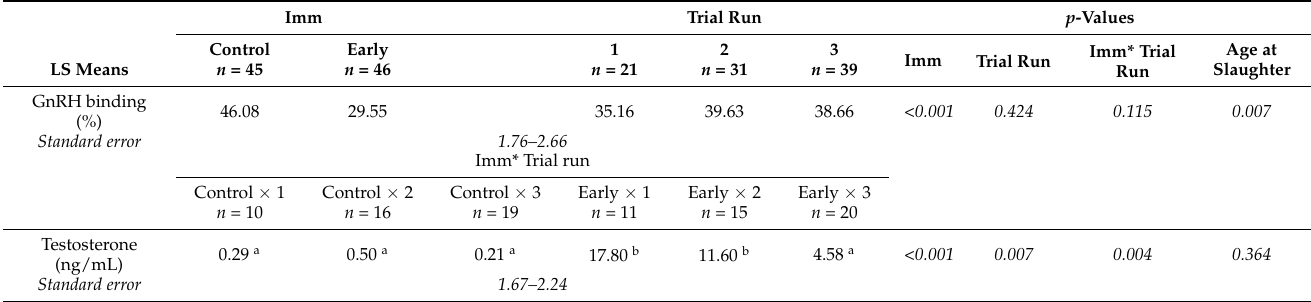
Table A4. GnRH binding and testosterone levels according to immunization scheme and trial run